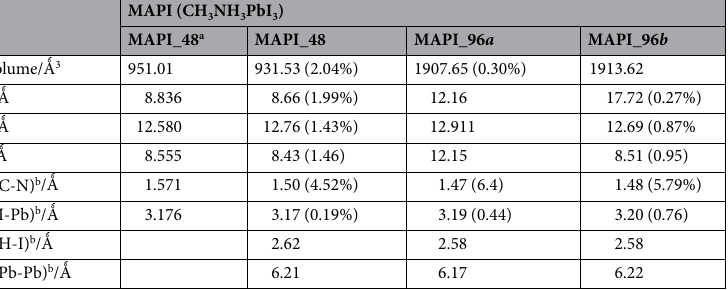
Table 1. Lattice parameters, bond distances and cell volumes obtained from optimized crystal structure of MAPI perovskite (CH 3 NH 3 PbI 3 ) for the unit cell with 48 atoms (MAPI_48), and two larger 96-atoms supercells: (a) with a ≈ b ≈ c (MAPI_96 a ) and (b) 2 × 1 × 1 supercell, i.e . replicating lattice parameter a (MAPI_96 b ). Values in parentheses stand for Relative errors between experimental and theoretical results. a Experimental data